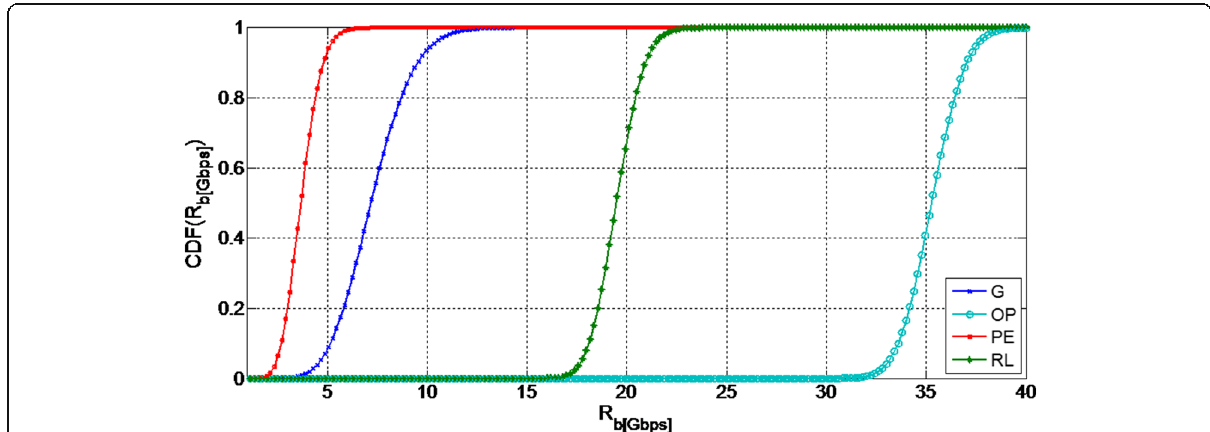
Fig. 3 CDF of the total network data rate for different approaches